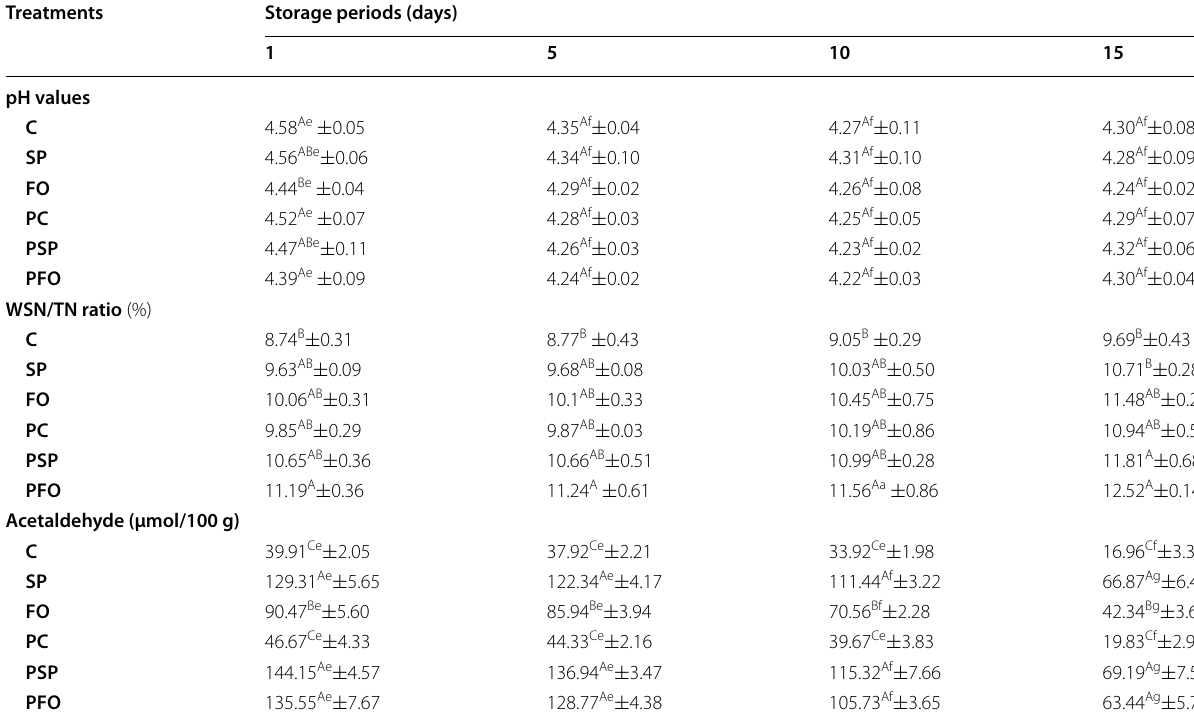
Table 4 Biochemical changes of probiotic and non‑probiotic yoghurt made from ewes’ milk fed a diet supplemented with Spirulina platensis or fish oil during storage at 5 2 °C for 15 days ±